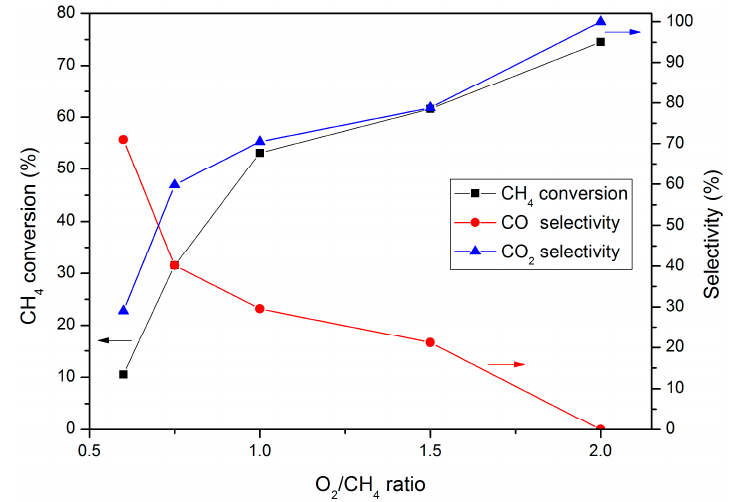
Figure 10. Effect of varying O 2 /CH 4 ratio on activity of 2Cr3Ru/Al 2 O 3 catalyst. Reaction conditions: feed gas O 2 /CH 4 volume ratio = 3/5–2/1 or 0.6–2.0, GHSV = 15,000 h − 1 , and reactor temperature = 475 °C.